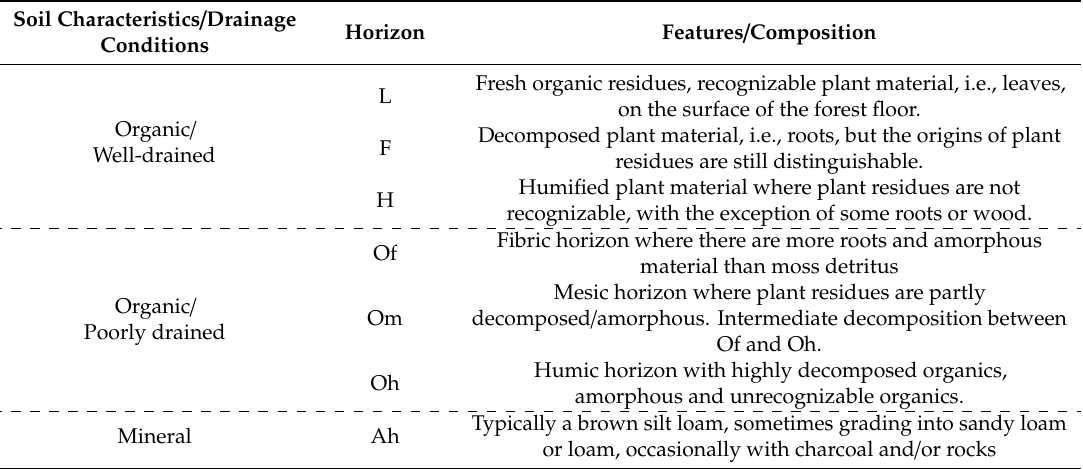
Table 1. Soil horizon characteristics according to the Canadian Soil